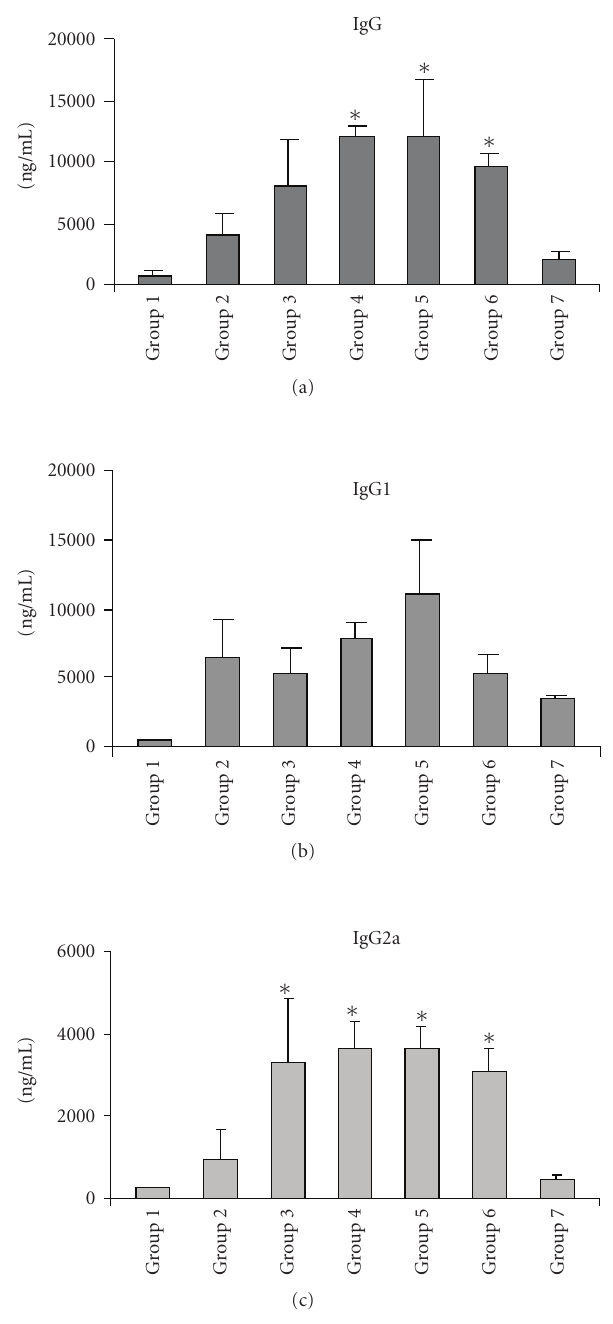
Figure 4: Comparison of antibody responses induced by immu- nization with the HIV Env-DNA and SHIV 89.6 VLP vaccines in di ff erent combinations. Mice were immunized by di ff erent vaccine preparations as described in Figure 2. Sera were collected at 2 weeks after the second immunization and analyzed for antibodies specific for HIV 89.6 gp120 by ELISA. The levels of antibody responses are expressed as the quantity (ng) of antibodies binding to HIV 89.6 gp120 in 1mL sera from each mouse. (a) Total IgG antibodies against gp120. (b) IgG1 subtype antibodies against gp120. (c) IgG2a subtype antibodies against gp120. Error bars indicate the standard deviations for each immunization group. ∗ indicates the groups with significantly higher levels of antibody responses than Group 2 that received the HIV Env-DNA vaccine only ( P < .